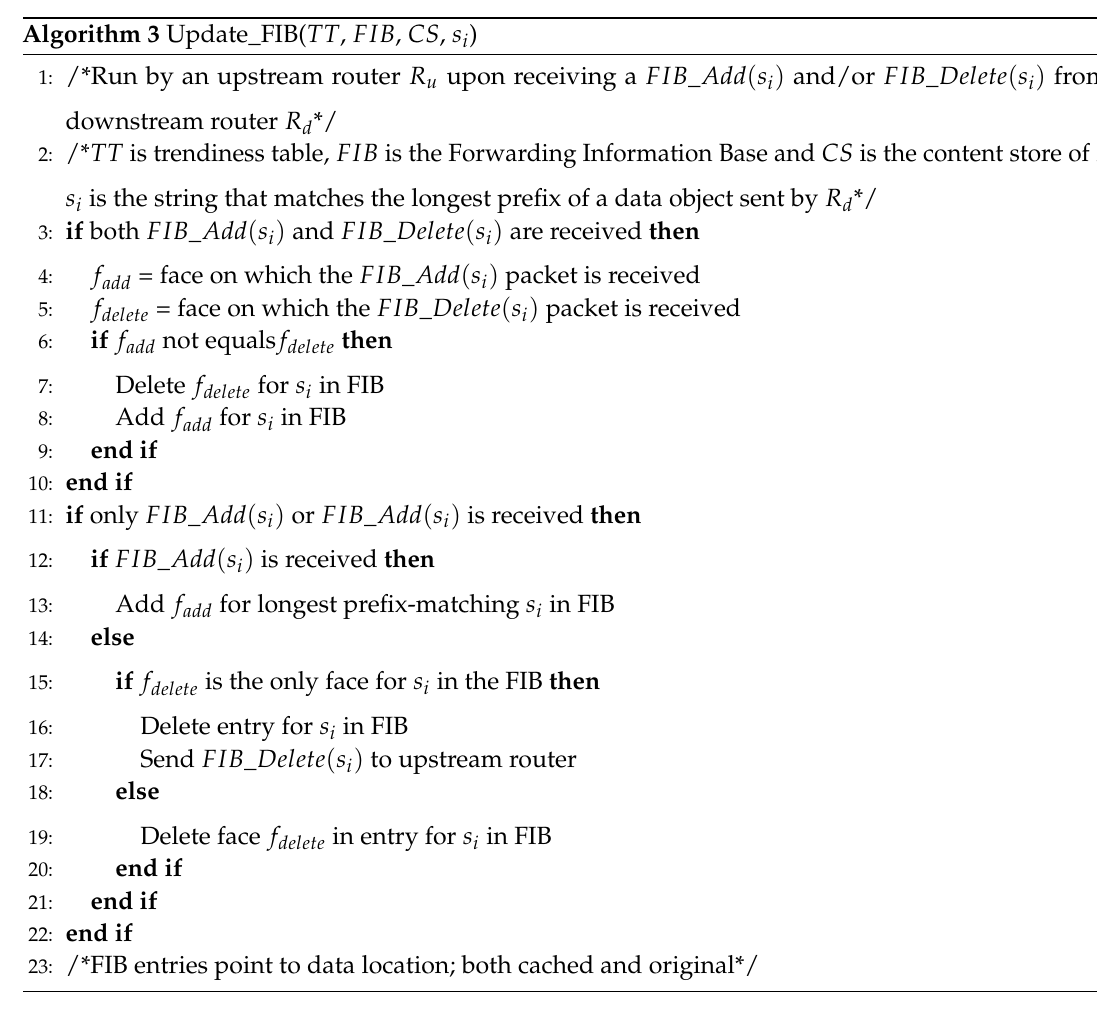
Algorithm 3 Update_FIB( TT , FIB , CS , s i